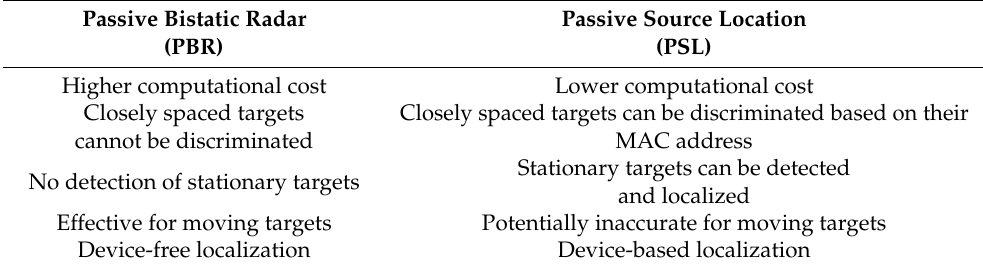
Table 1. The PBR and PSL